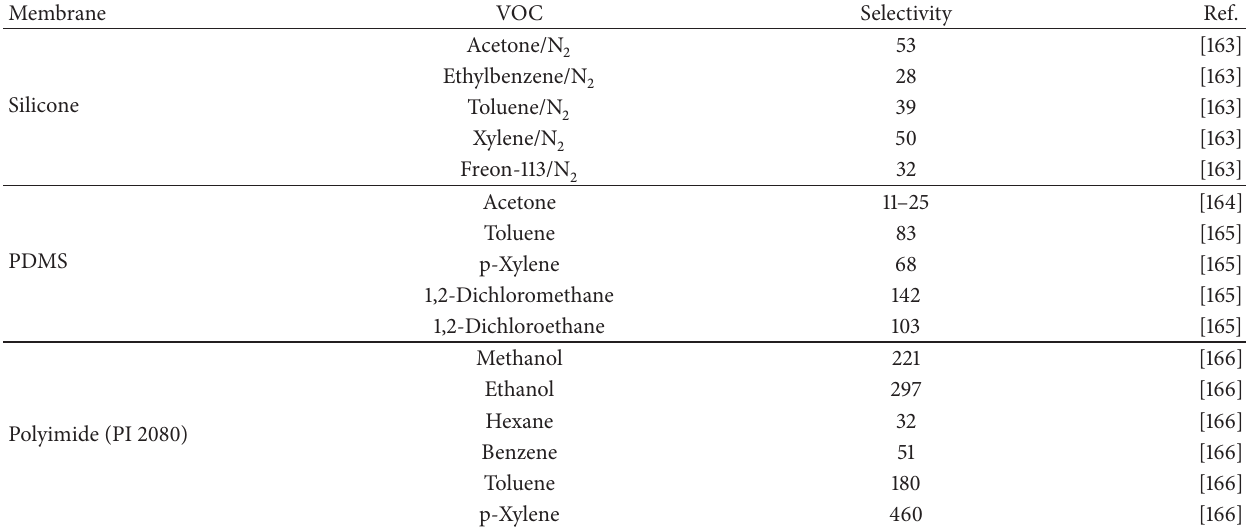
Table 13: Selectivity of various membranes from VOC separation from air (or N 2 if stated).